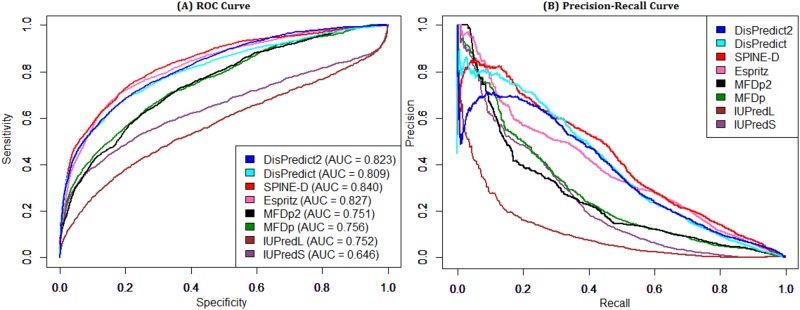
ROC and precision-recall curves given by 8 disorder predictors for CASP9 dataset.Comparison of disorder predictors in terms of (A) ROC curve and (B) precision-recall curve on CASP9 dataset. The area under ROC curves are given in the plot (A).